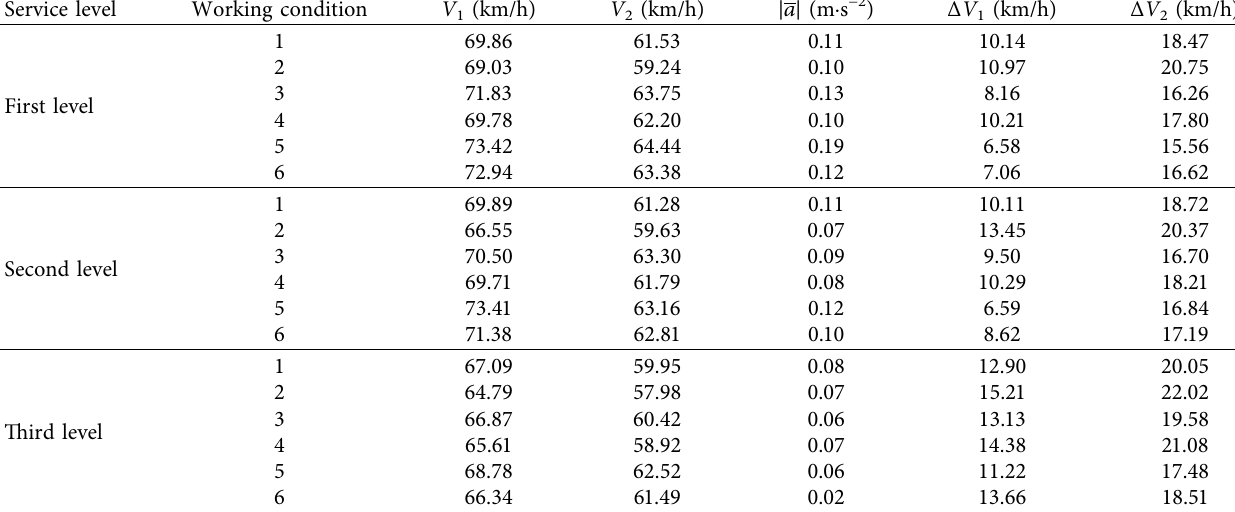
Table 4: Average speed and acceleration at different sections within 200m after the tunnel exit. Service